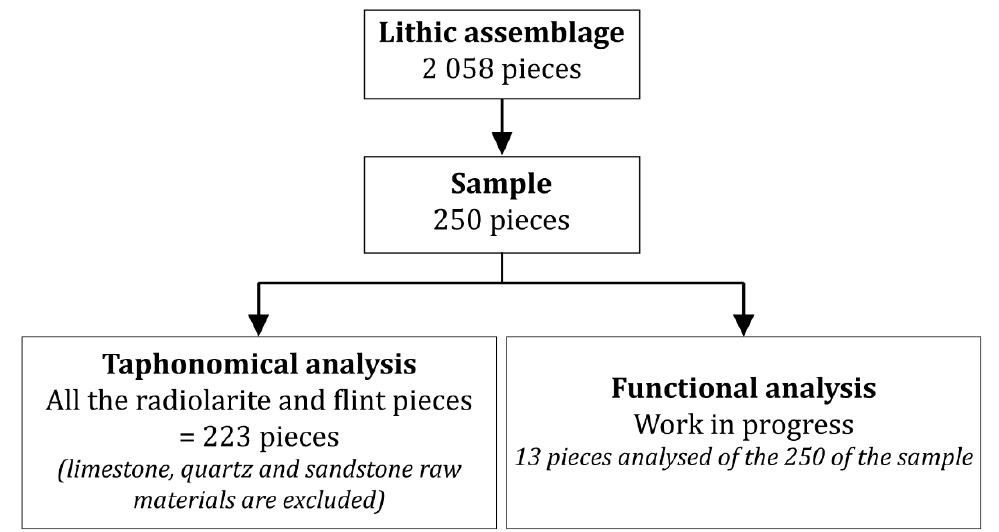
Figure 2. Details of sampling and stages of